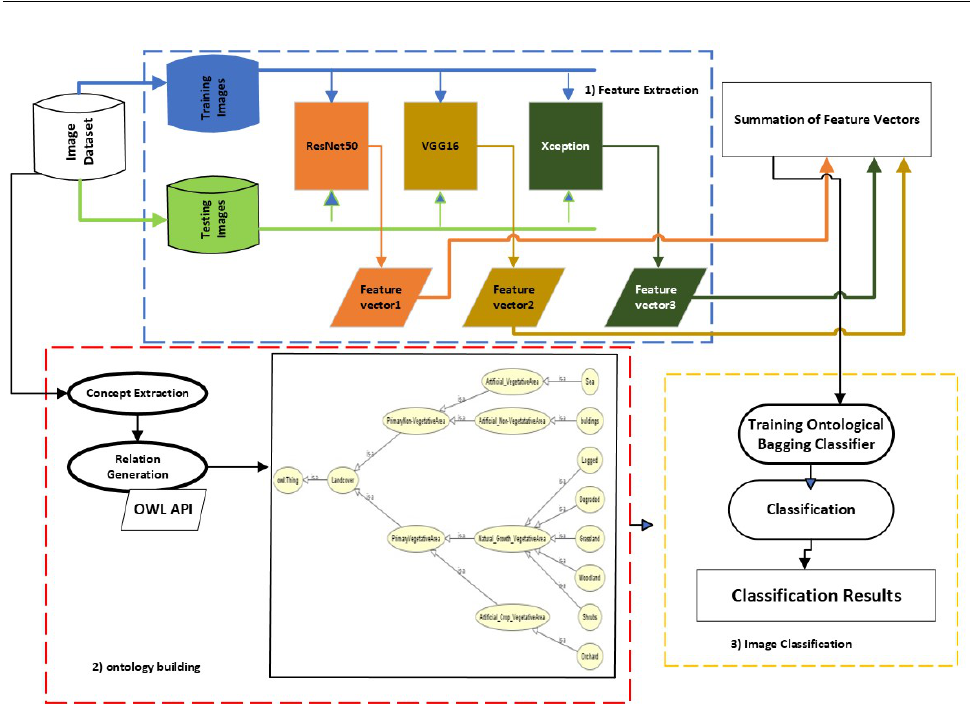
Figure 5. The proposed